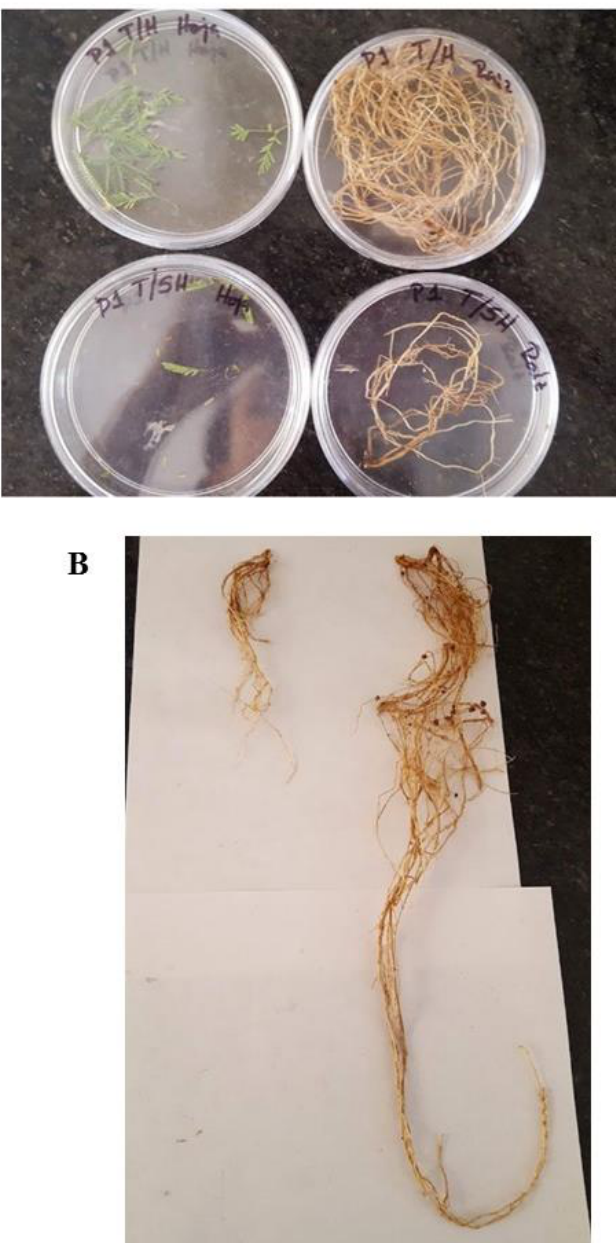
Figure 7. Representative images of a P. laevigata specimen grown in control substrate in the presence or absence of the strain A. luchuensis C7. ( A ) Foliar (left) and root (right) biomass collected from a P. laevigata in the presence (upper images) or absence (lower images) of A. luchuensis C7. ( B ) Root length of a representative P. laevigata plant in the presence (upper images) or absence (lower image) of strain A. luchuensis C7.